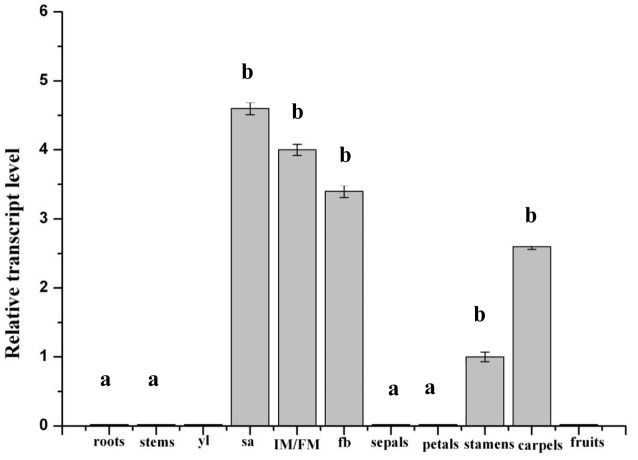
Profiling of SlWUS transcript accumulation in wild-type tomato plant tissues monitored by qRT-PCR. Samples were collected from the Solanum pimpinellifolium ‘Zhongshu 6.’ The level for stamens was used as a reference. yl, young leaves; sa, shoot apexes; IM/FM, infloresence meristem/floral meristem; yfb, young floral buds. The data are the mean values corresponding to three independent experiments. The error bars represent the standard errors. Values followed by the same letter (a or b) are not significantly different (P > 0.05, Duncan’s multiple range test).